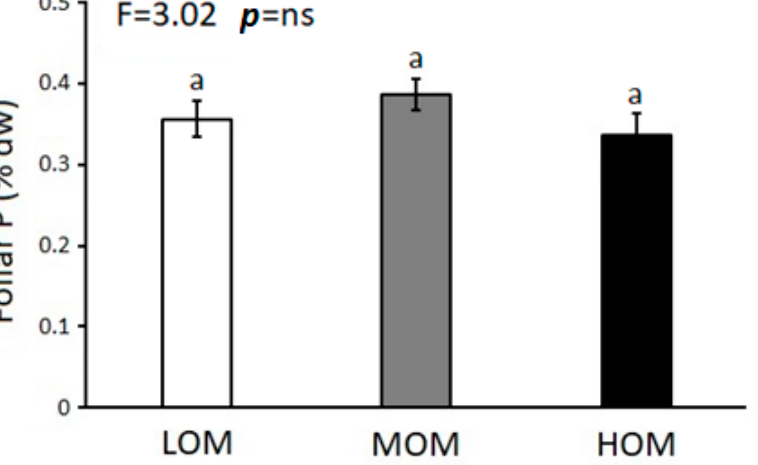
Figure 4. Foliar phosphorus (P) concentrations ( ± SE) under different soil organic matter contents. No statistically significant differences between the treatments were revealed by the ANOVA (ns: non-significant).